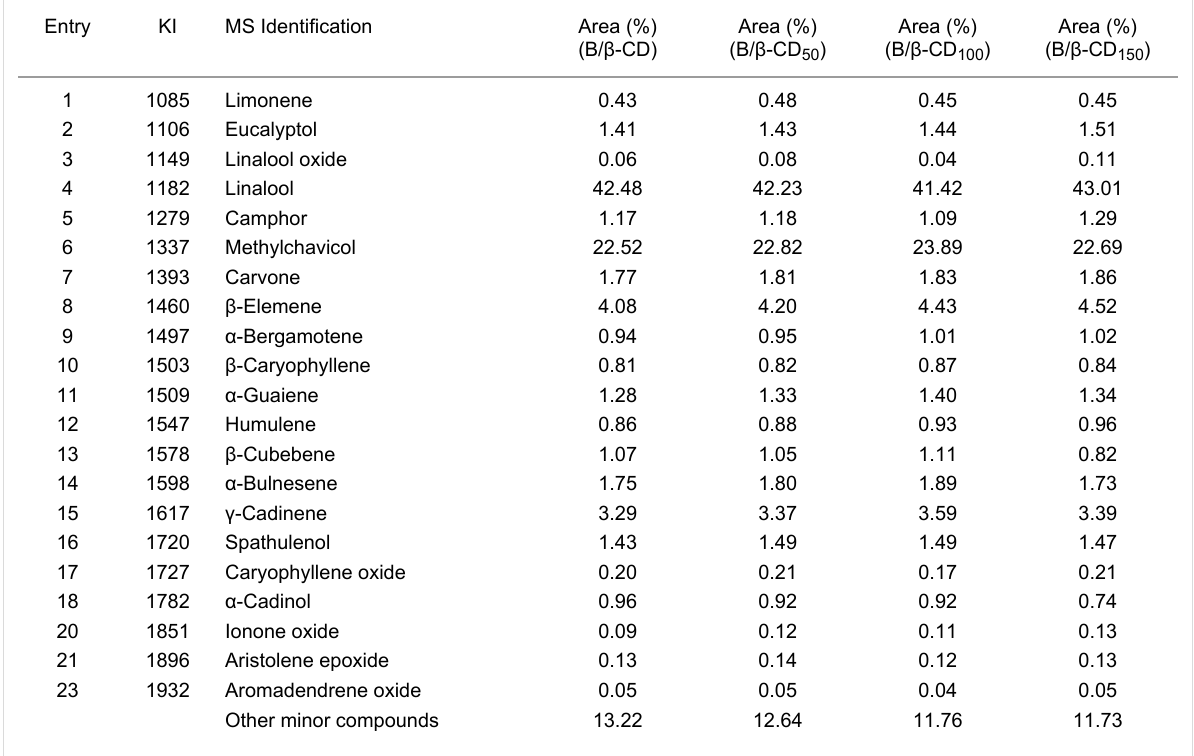
Table 3: The GC–MS data for the O. basilicum essential oil recovered from the non-degraded and thermal/oxidative degraded β -CD complex (at various temperatures; B/ β -CD – non-degraded O. basilicum L. essential oil/ β -CD complex, B/ β -CD 50,100,150 – degraded O. basilicum L. essential oil/ β -CD complex at a degradation temperatures of 50 °C, 100 °C, and 150 °C, respectively). The numbers for the compounds correspond to those from Table 1 and Table 2.